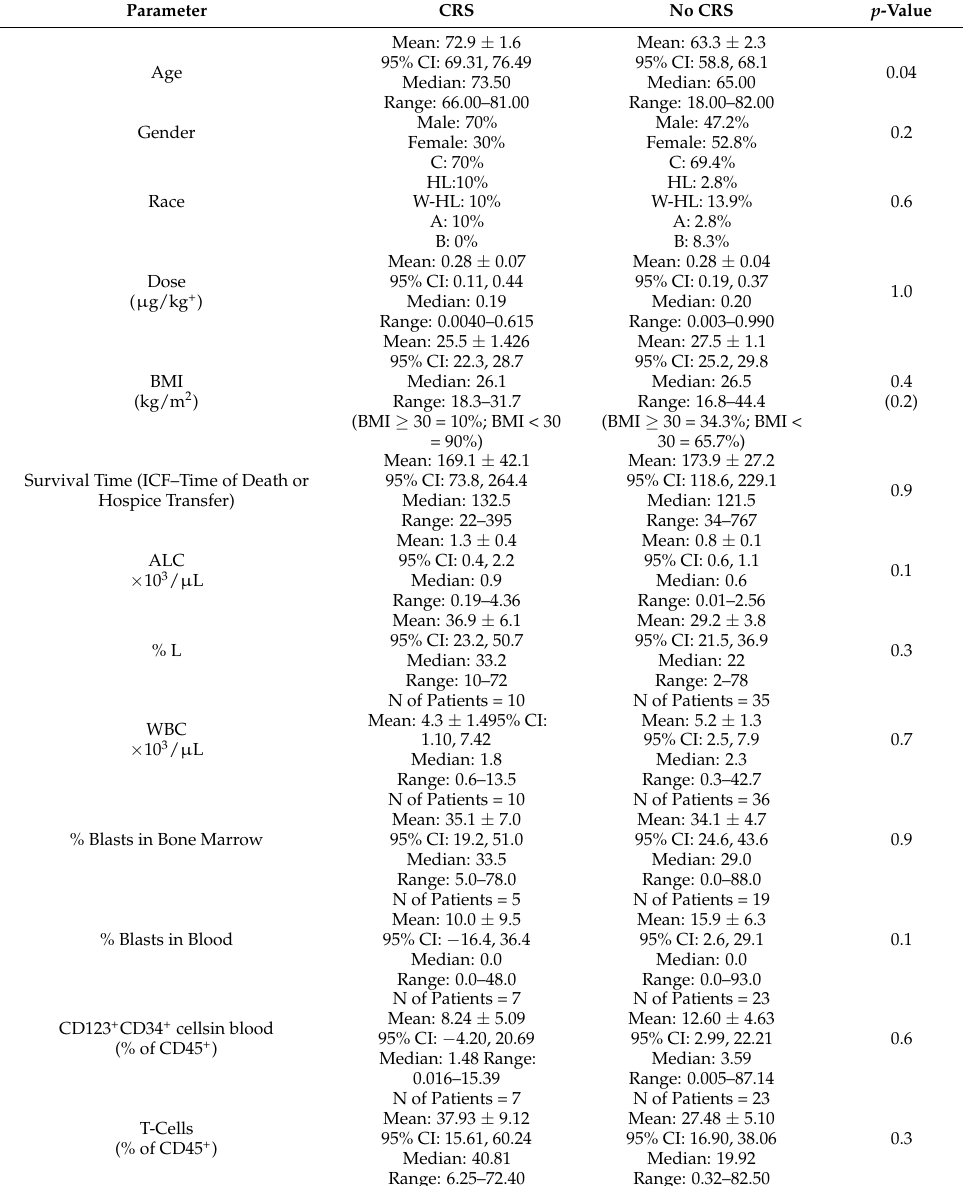
Table 2. Predictors of CRS and its impact on